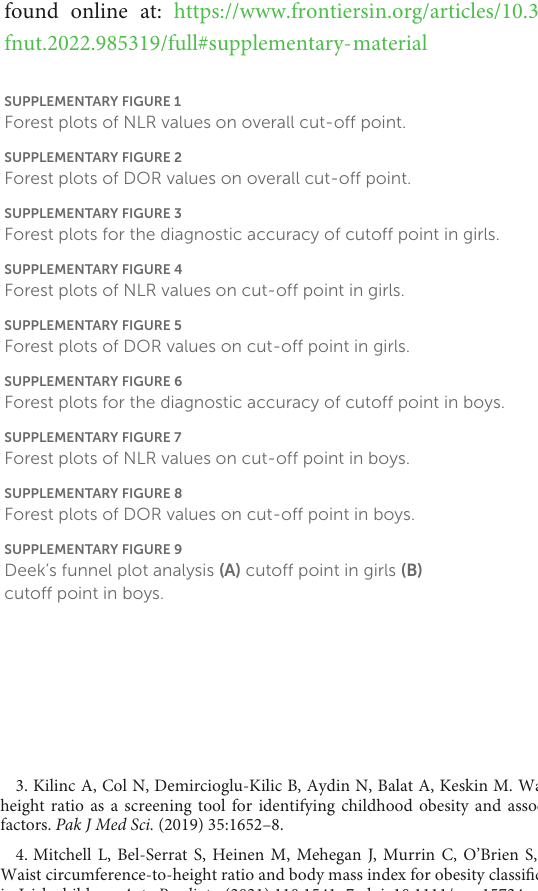
SUPPLEMENTARYFIGURE1 Forest plots of NLR values on overall cut-off point. SUPPLEMENTARYFIGURE2 Forest plots of DOR values on overall cut-off point. SUPPLEMENTARYFIGURE3 Forest plots for the diagnostic accuracy of cutoff point in girls. SUPPLEMENTARYFIGURE4 Forest plots of NLR values on cut-off point in girls. SUPPLEMENTARYFIGURE5 Forest plots of DOR values on cut-off point in girls. SUPPLEMENTARYFIGURE6 Forest plots for the diagnostic accuracy of cutoff point in boys. SUPPLEMENTARYFIGURE7 Forest plots of NLR values on cut-off point in boys. SUPPLEMENTARYFIGURE8 Forest plots of DOR values on cut-off point in boys. SUPPLEMENTARYFIGURE9 Deek’s funnel plot analysis (A) cutoff point in girls (B) cutoff point in